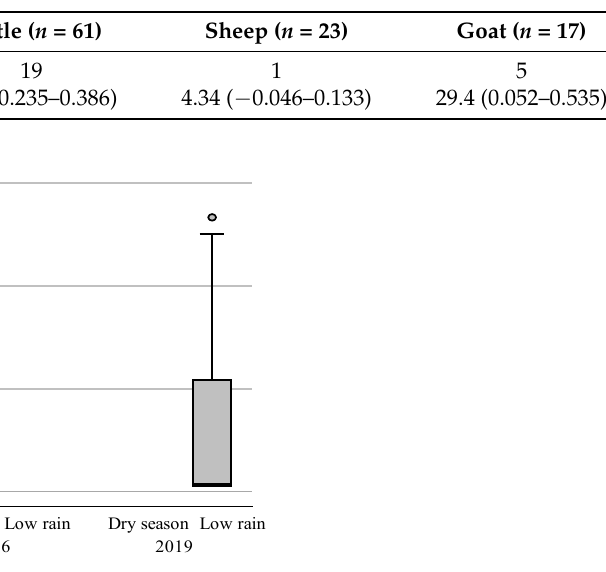
Figure 3. Individual optical density (OD) value by ELISA in different seasons during the sampling years of the surveyed cattle relative to manufacturer’s instructions [29]. Bars represent the 95% confidence interval of the measure. Table 4. Multiple logistic regression analysis for association between studied variables and CCHF serological outcomes in Kenya.